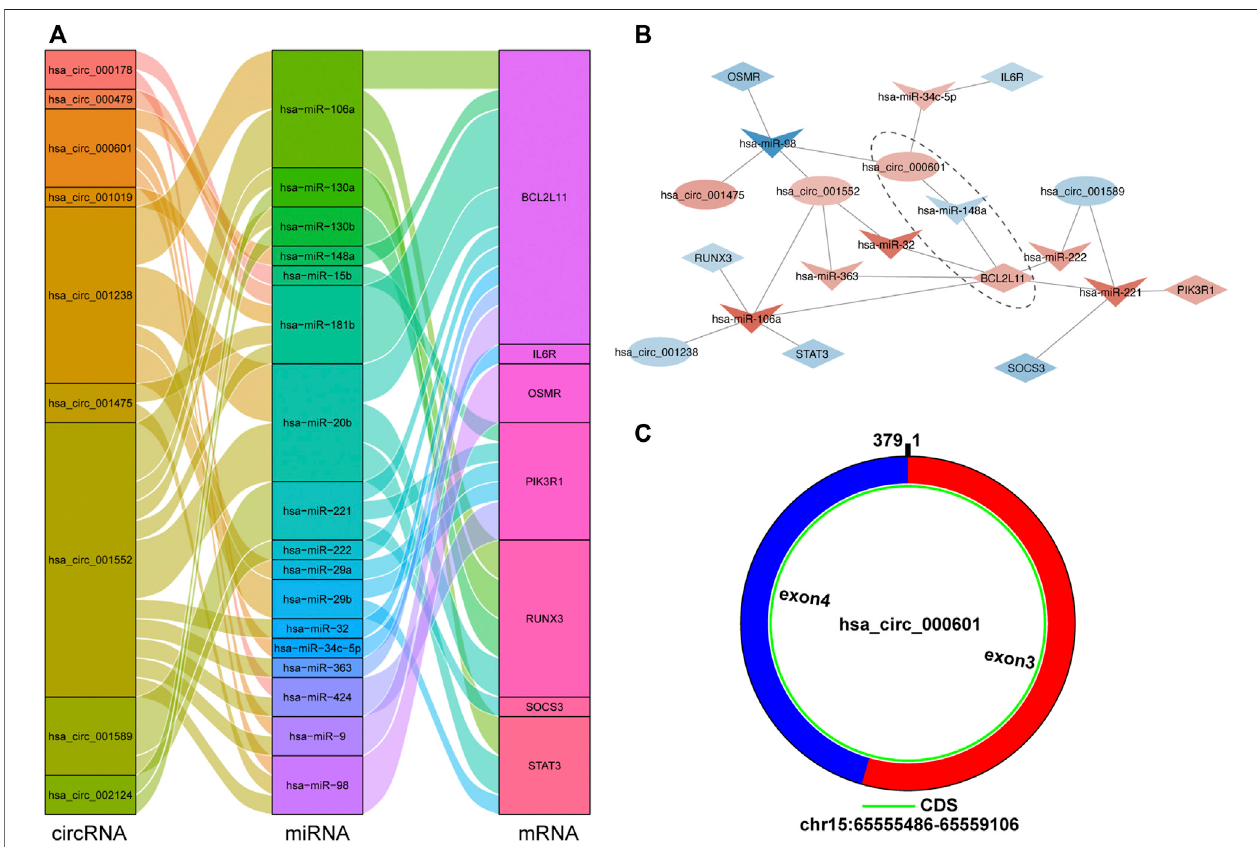
FIGURE 10 | The circRNA-miRNA-hub gene subnetwork and crucial signaling pathway axis. (A) The Sankey diagram of the subnetwork in TOF. Each rectangle represents an element (circRNA, miRNA, mRNA), and the size of the rectangle indicates the degree of connection of each component. (B) Identi fi cation of crucial signaling pathway axis. Red indicates up-regulation, blue indicates down-regulation, and color depth indicates up-regulation degree. (C) Predicted the structure of hsa_circ_000601 based on the CircPrimer software.